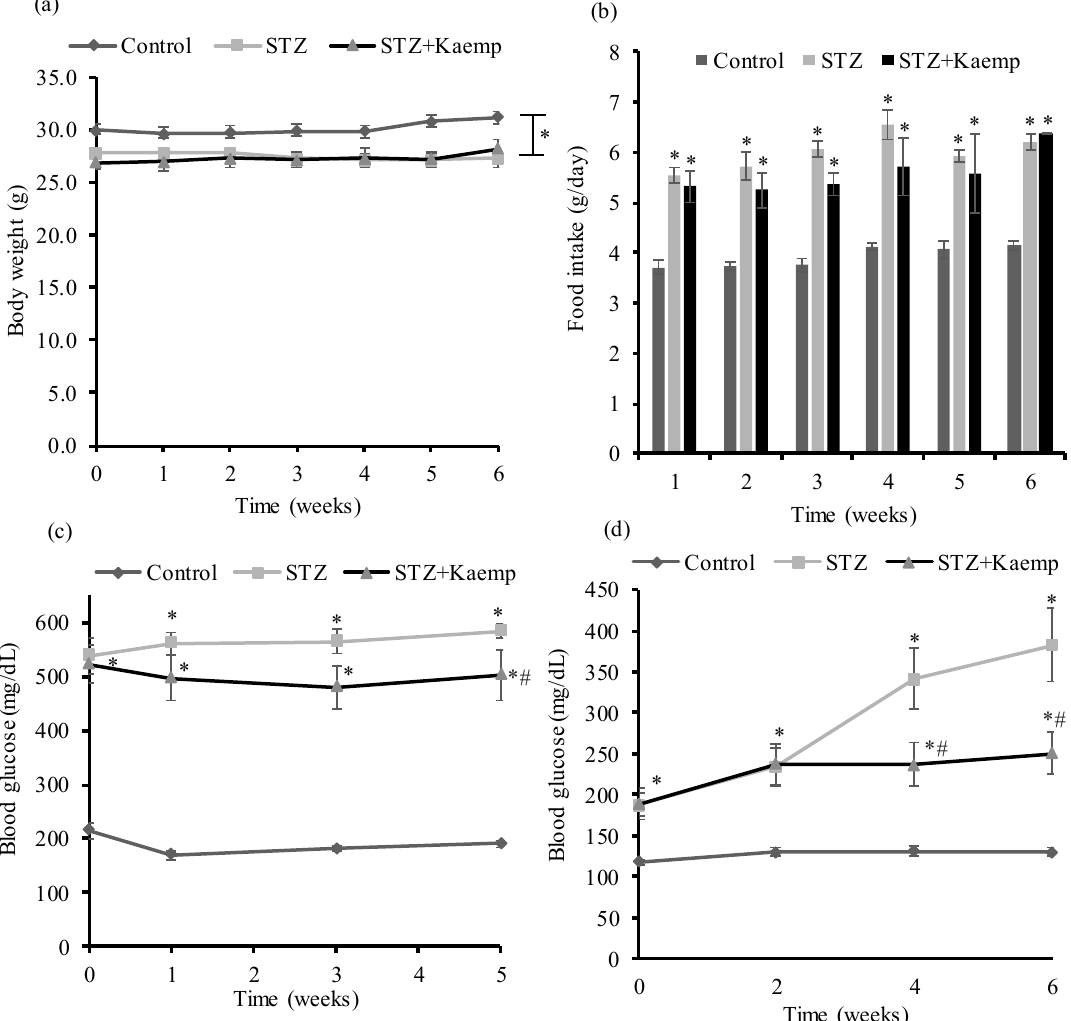
Figure 3. Kaempferol treatment for 6 weeks improved hyperglycemia without altering BW or food intake in STZ-induced severely diabetic mice. ( a ) BW was measured every week. ( b ) Food intake was measured weekly and are expressed as daily food intake. ( c ) Non-fasting and ( d ) fasting blood glucose levels were measured at indicated time points of dietary treatment. Data are shown as Mean ± SEM ( n = 8–9). * p < 0.05 vs. non-diabetic mice; # vs. STZ-induced diabetic mice. Control: nondiabetic mice; STZ: STZ-induced diabetic mice; STZ + Kaemp: STZ-induced diabetic mice treated with kaempferol (50 mg/kg